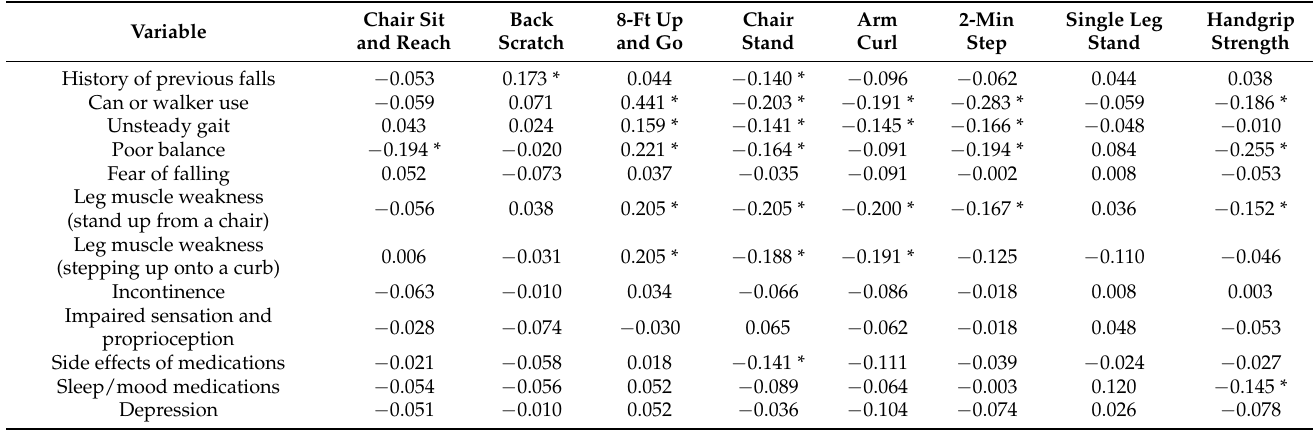
Table 3. Correlations between the fall risk questionnaire items and physical